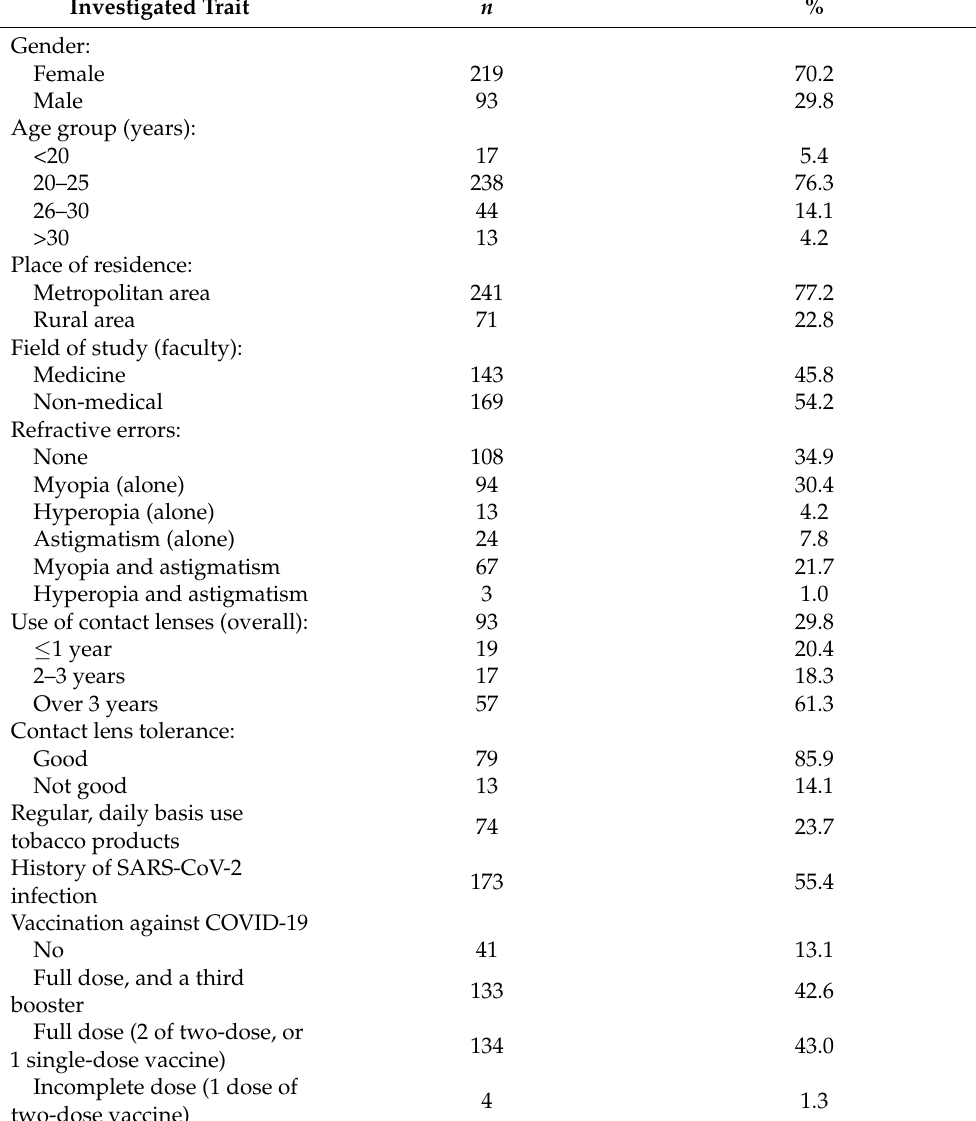
Table 1. Baseline socio-demographic and clinical characteristics of the study cohort ( n =